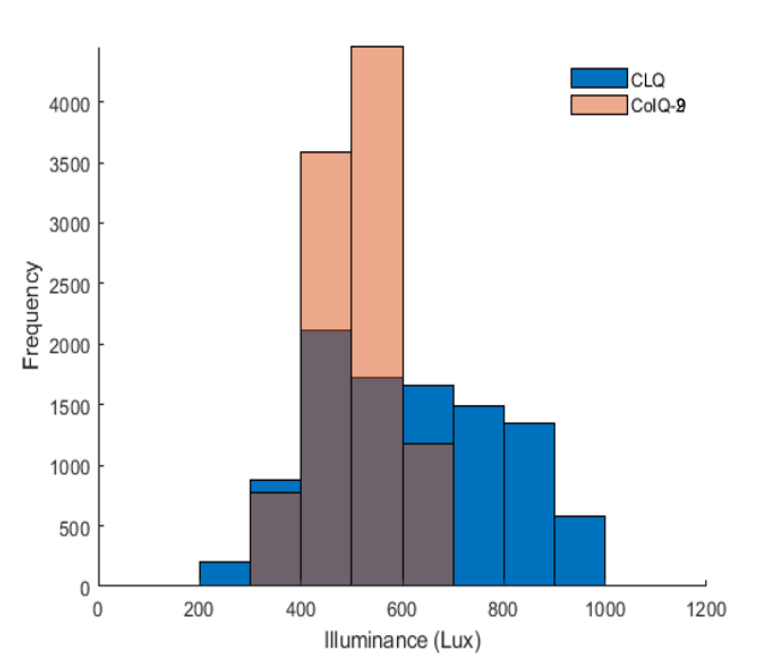
Figure 6. Illuminance histograms for CLQ and